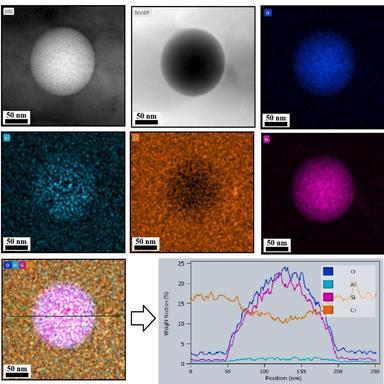
The HR-STEM/EDS elemental maps for Al2O3 nanoparticles.